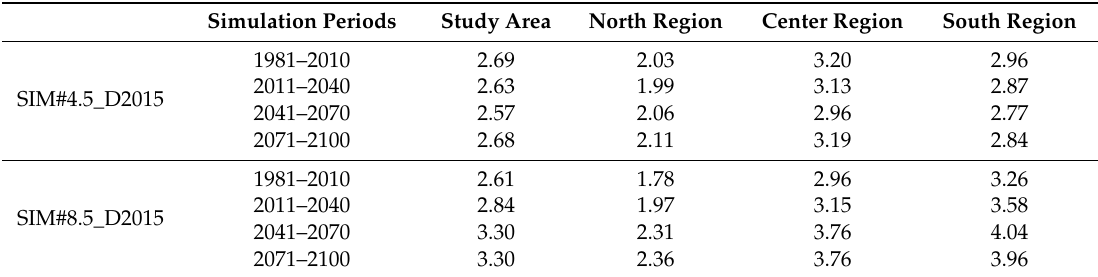
Figure 13. Soil erosion rate anomaly with respect to the reference period (1981–2010) for: 2011–2040 (first column), 2041–2070 (second column), and 2071–2100 (third column). SIM#4.5_D2015 (first row) and SIM#8.5_D2015 (second row). Table 7. Mean erosion rates [t ha − 1 yr − 1 ] according to climate